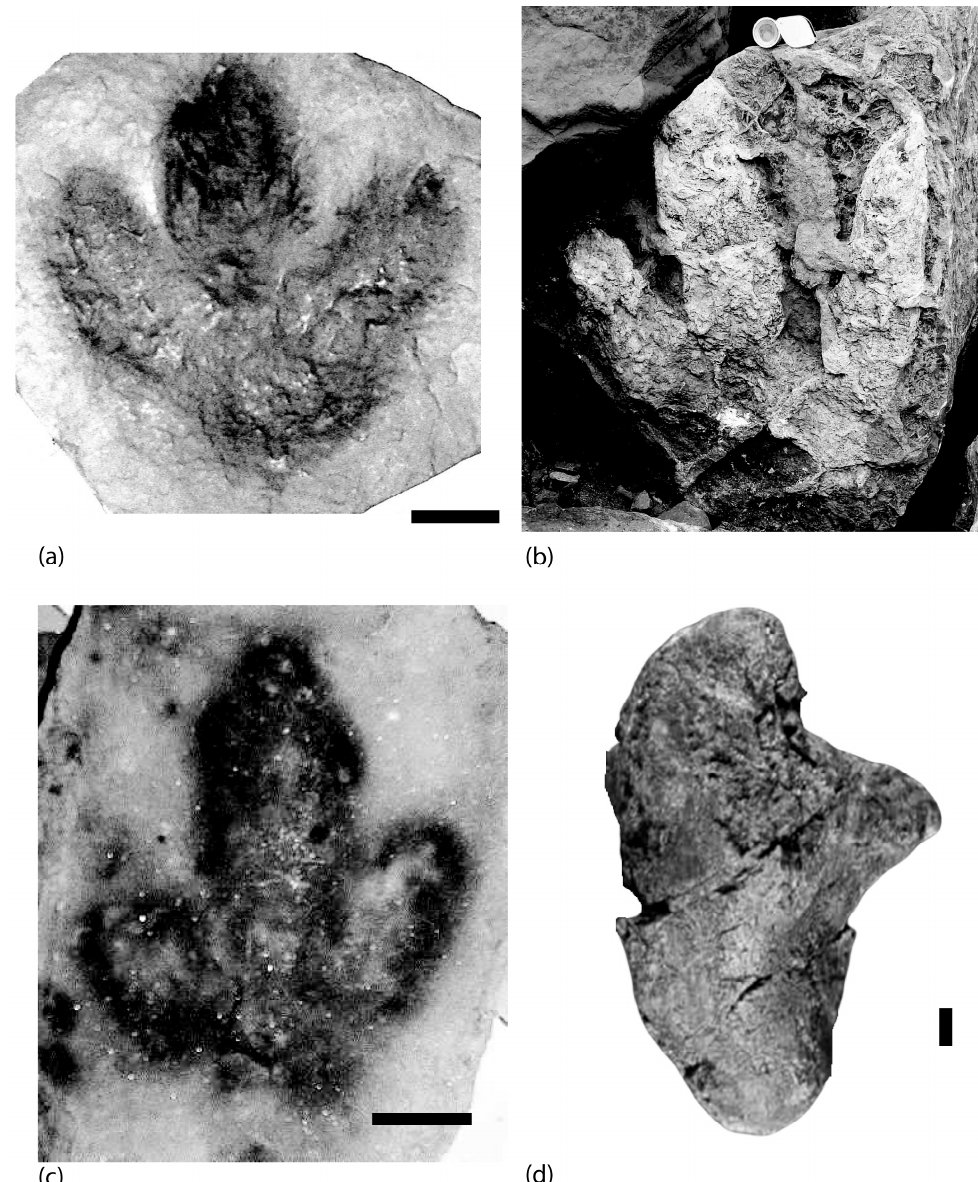
Figure 3. Examples of ornithischian remains, and possible ornithopod footprints from the Trotternish Peninsula, Isle of Skye, ( a ) Lealt Shale Formation footprint (GLAHM V1980); ( b ) large footprint from the Valtos Formation loose block on foreshore near Dùn Dearg, Valtos; ( c ) Duntulm Formation level B at An Corran, near Staffin (in the Paul and Cathie Booth private collection, Pitlochry); ( d ) proximal part of ulna of thyreophoran from the Bearreraig Formation in lateral view (SM 1977.1997.1), cast in the Hunterian (GLAHM 114092). Scalebar for ( a ) and ( b ) = 10 cm; ( c ) = 5 cm; ( d ) = 1 cm.